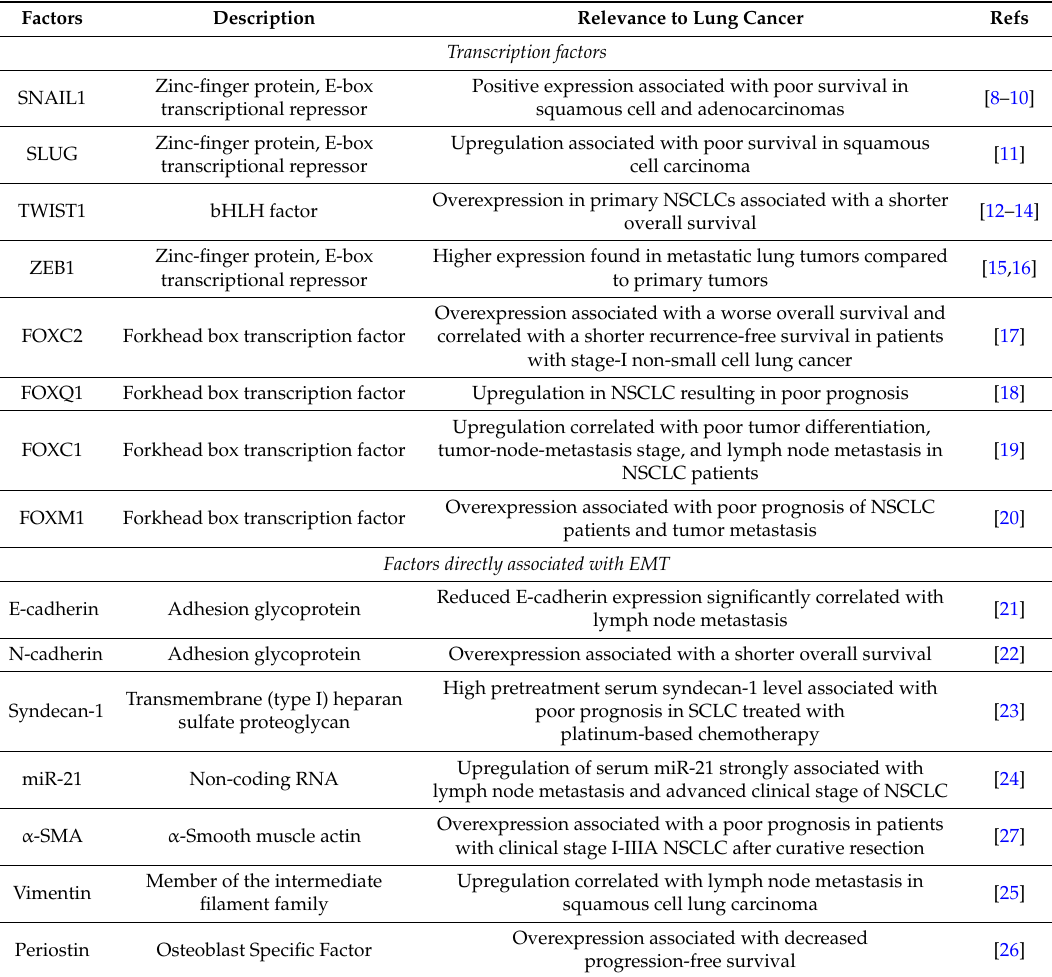
Table 1. Factors/Proteins involved in epithelial to mesenchymal transition (EMT) and their relevance to lung